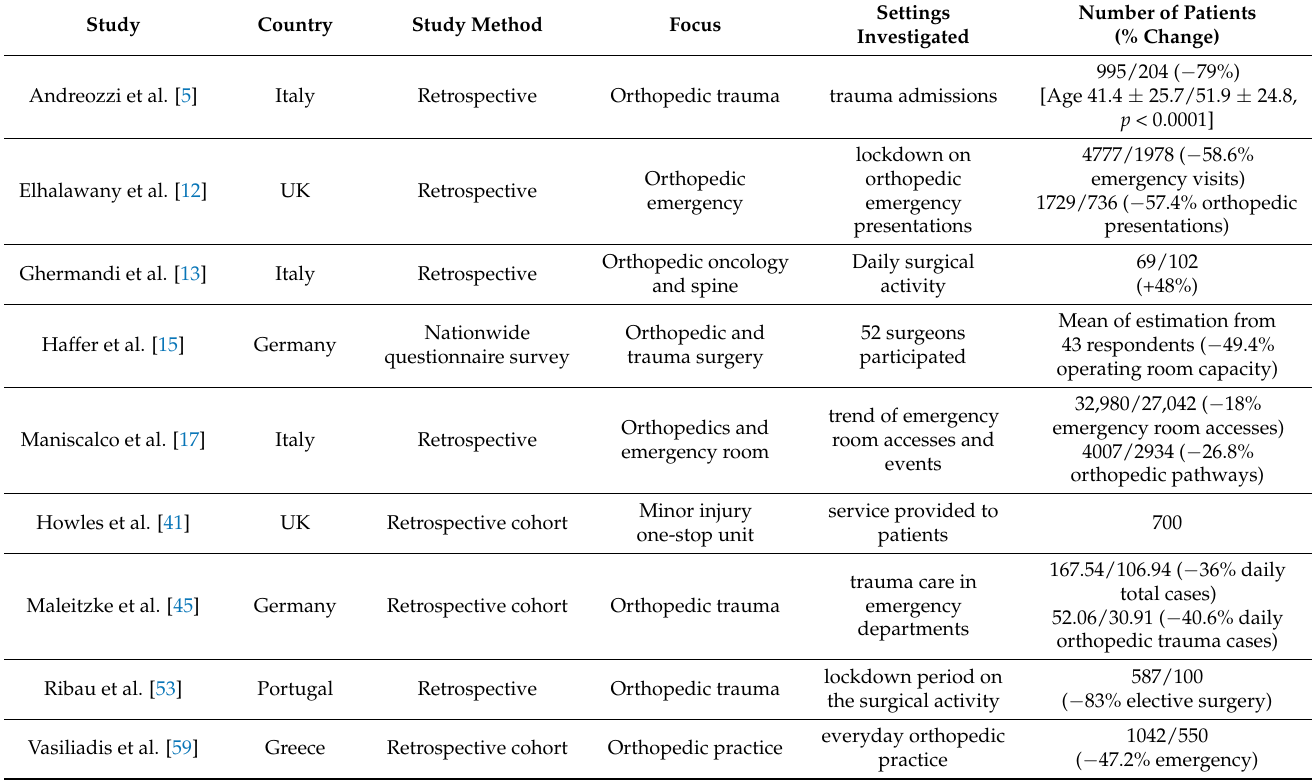
Table 4. Characteristics of relevant publications on orthopedic performance in